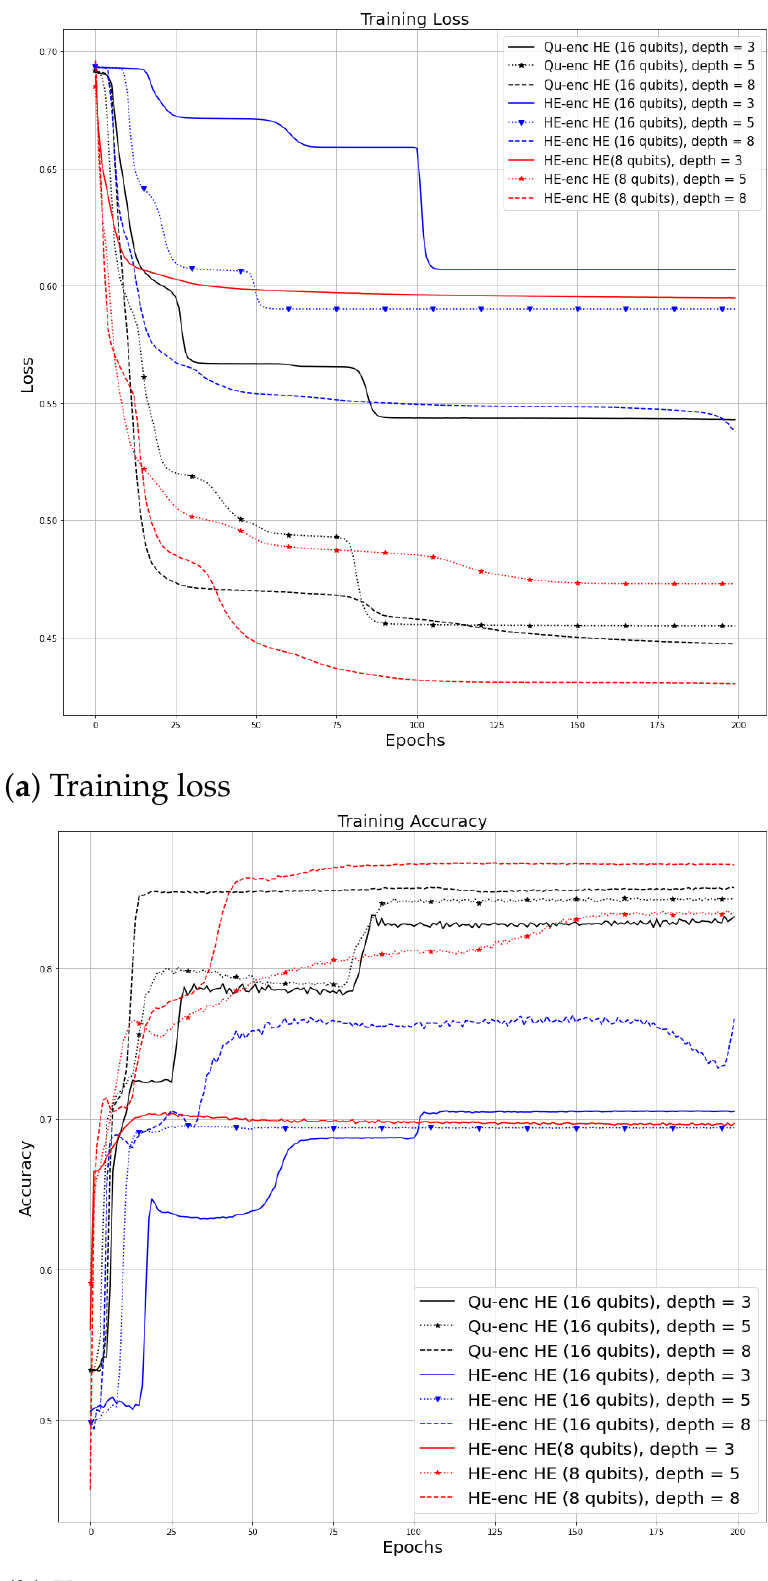
Figure 6. Learning curves in training of HE circuits